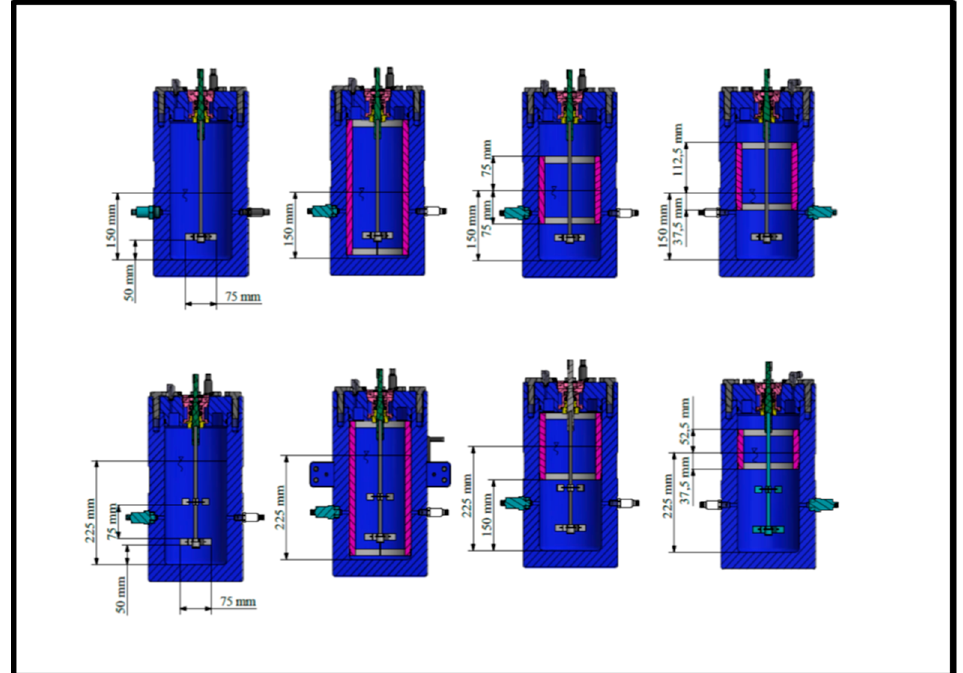
Figure 3. Dimensions of reactor, baffles and single and dual Rushton turbine (RT) impellers.